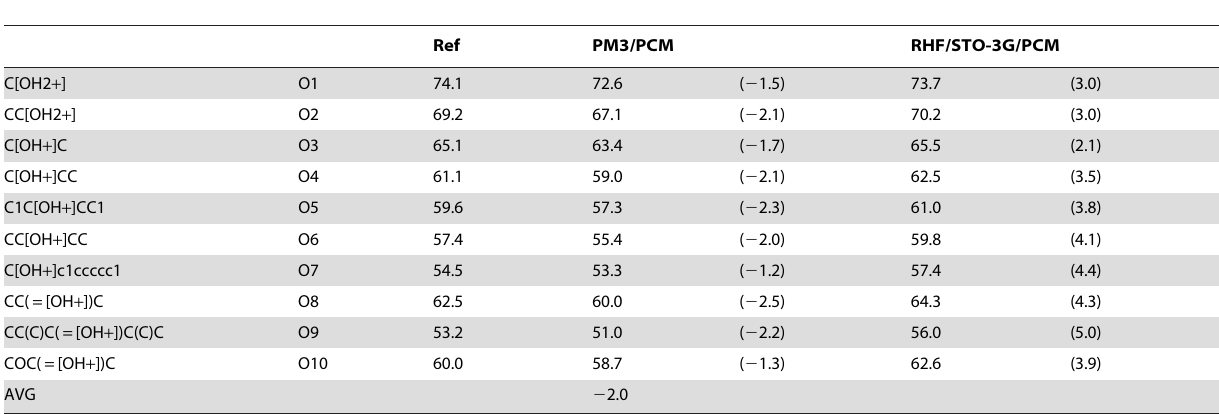
Table 3. Predicted electrostatic solvation free energies of oxonium type